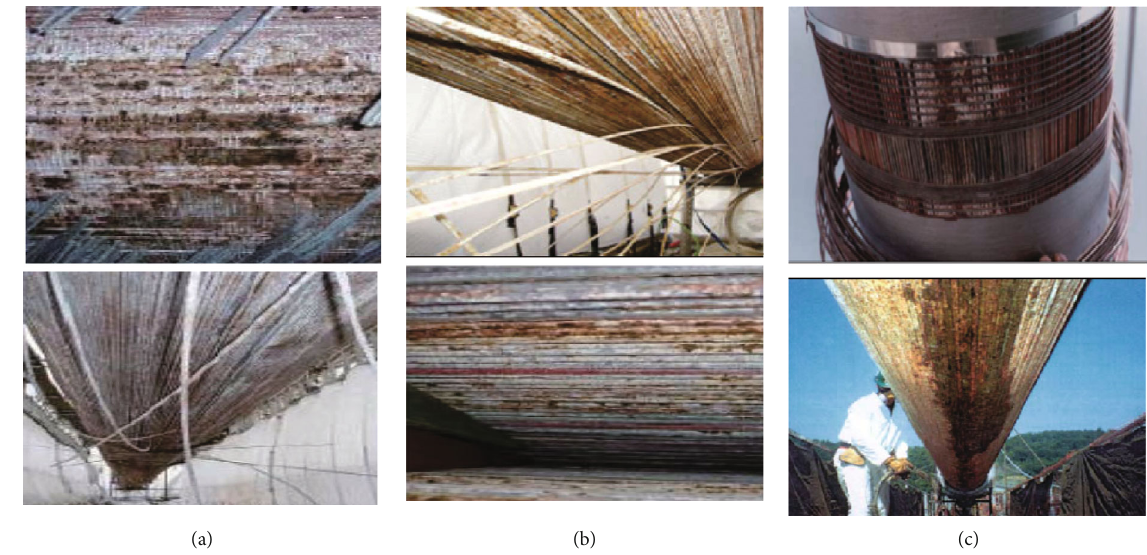
Figure 2: Corrosion of main cables on suspension bridge: (a) the Golden Gate Bridge, (b) Forth Road Bridge, and (c) Japan Dashima Bridge.